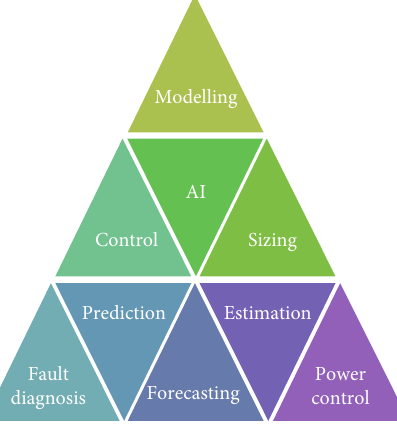
Figure 1: AI applications in solar panel.